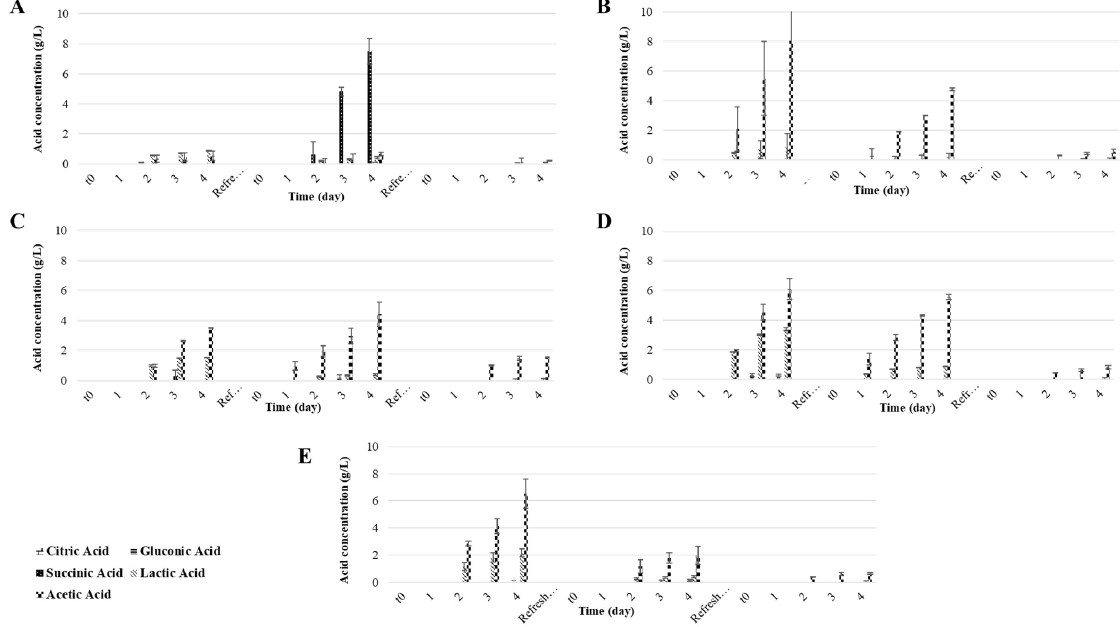
Figure 3. Organic acid development in water kefirs under nitrogen limitation. ( A ) CLUK, ( B ) FFUK, ( C ) KGIE, ( D ) CFUK, ( E ) KOUK. Table 3. Characteristics of water kefir fermentations performed under nitrogen limitation.